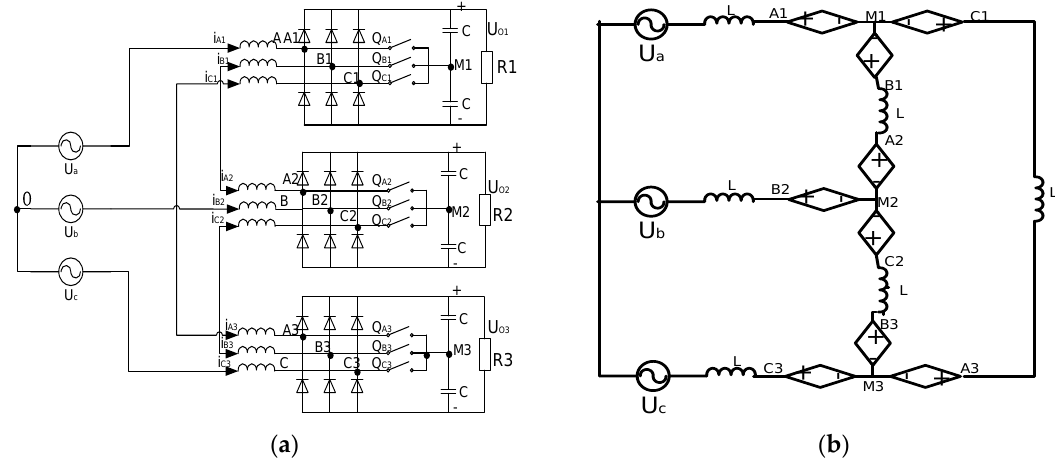
Figure 2. Triple line voltage cascaded VIENNA converter. ( a ) the schematic circuit diagram. ( b ) simplified connected structure diagram.